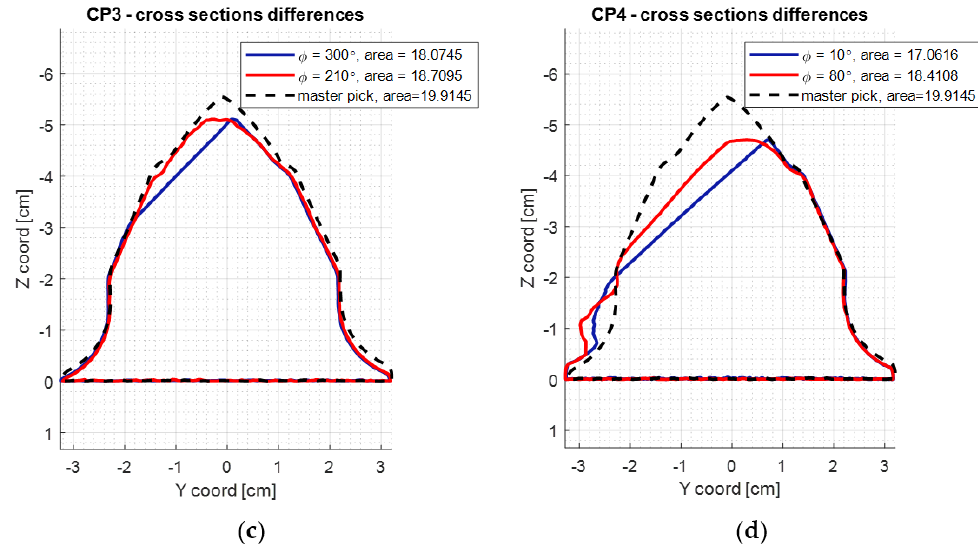
Figure 10. The difference between the minimal and maximal cross-section area of the scanned picks. ( a ) shows the min/max cross-sectional area of CP01 pick, ( b ) of CP02, ( c ) of CP03 and ( d ) of CP04. Their physical representation is shown in Figure 3. Cross-section boundary points of the pick nr 4 are considered to be worn out and are not suitable for regeneration. Table 6. Table containing the calculated data regarding the examined picks. The S parameter is a Boolean value assigned according to set threshold—in this case, the authors set the critical value at 3%. The threshold value may vary in the case of different tool geometry. The maximum plastic deformation coefficient calculates the area of surplus material, exceeding the contour of the master model cross-section.